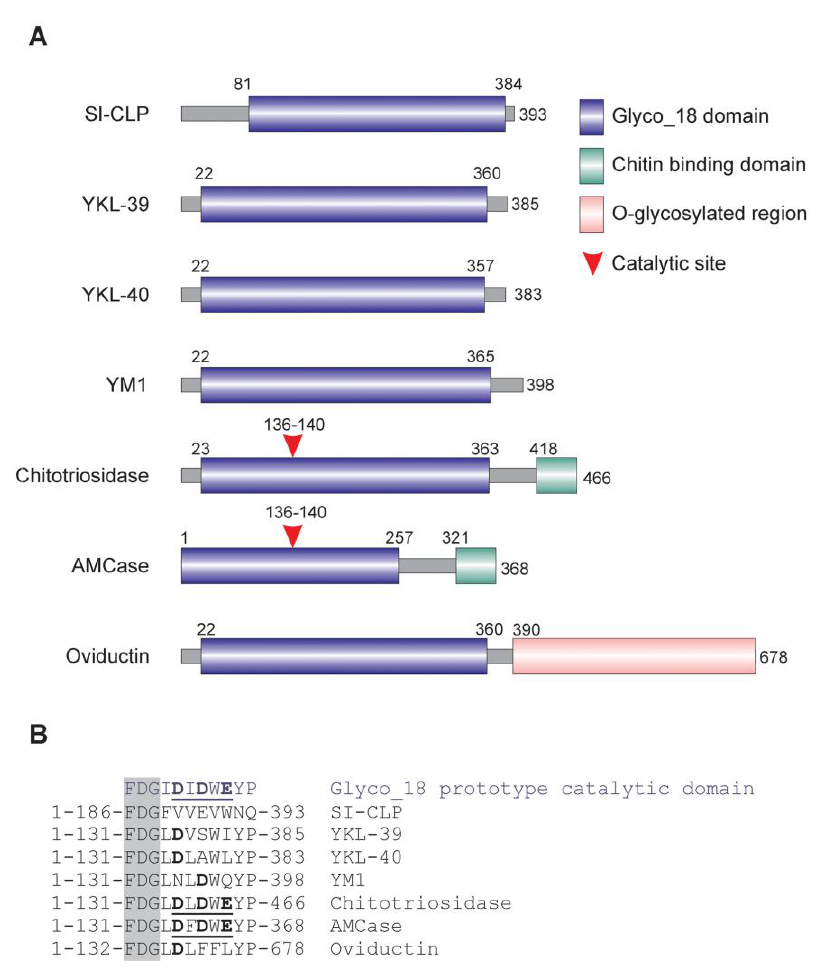
FIGURE 3. SI-CLP is a novel member of Glyco_18 domain–containing human chitinases and chitinase-like proteins. (A) Schematic presentation of mammalian Glyco_18 domain–containing proteins. (B) Critical amino acid in catalytic sites. The characteristic FDG sequence preceding the catalytic motif is shown in shadowed box. Catalytic amino acids are shown in bold.